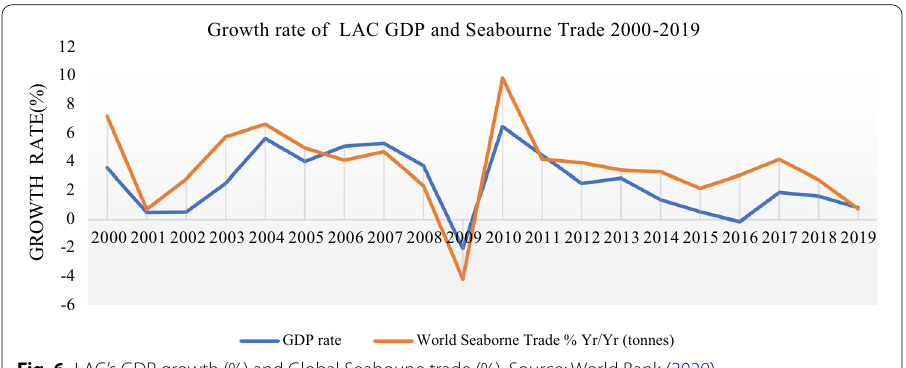
Fig. 6 LAC’s GDP growth (%) and Global Seaboune trade (%). Source: World Bank